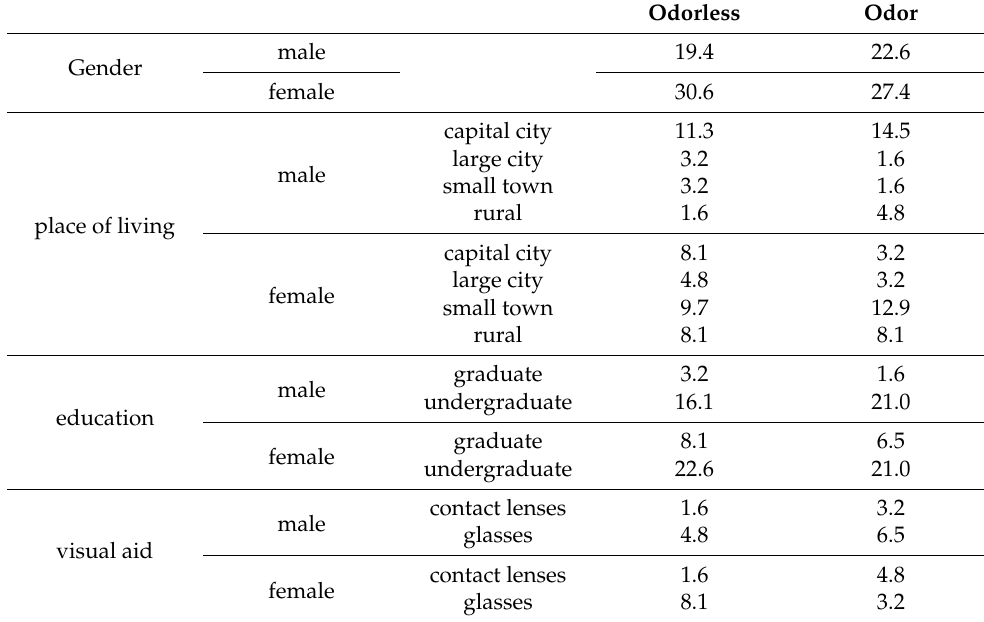
Table 1. Demographic profile of the participants in the odor and odorless conditions